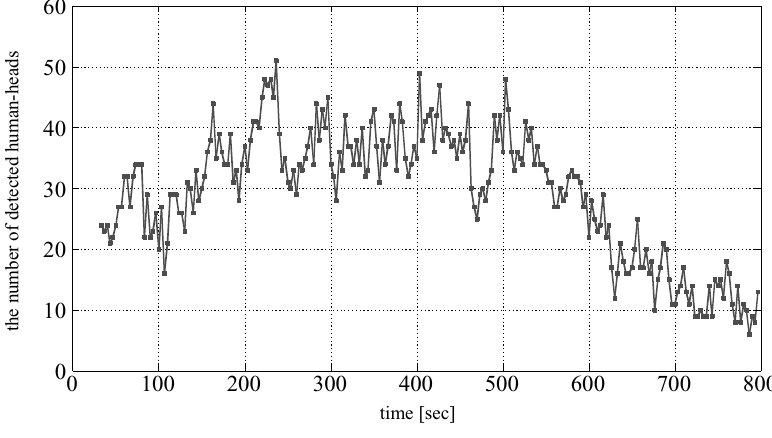
Fig. 9. Time-history of the number of detected human heads.